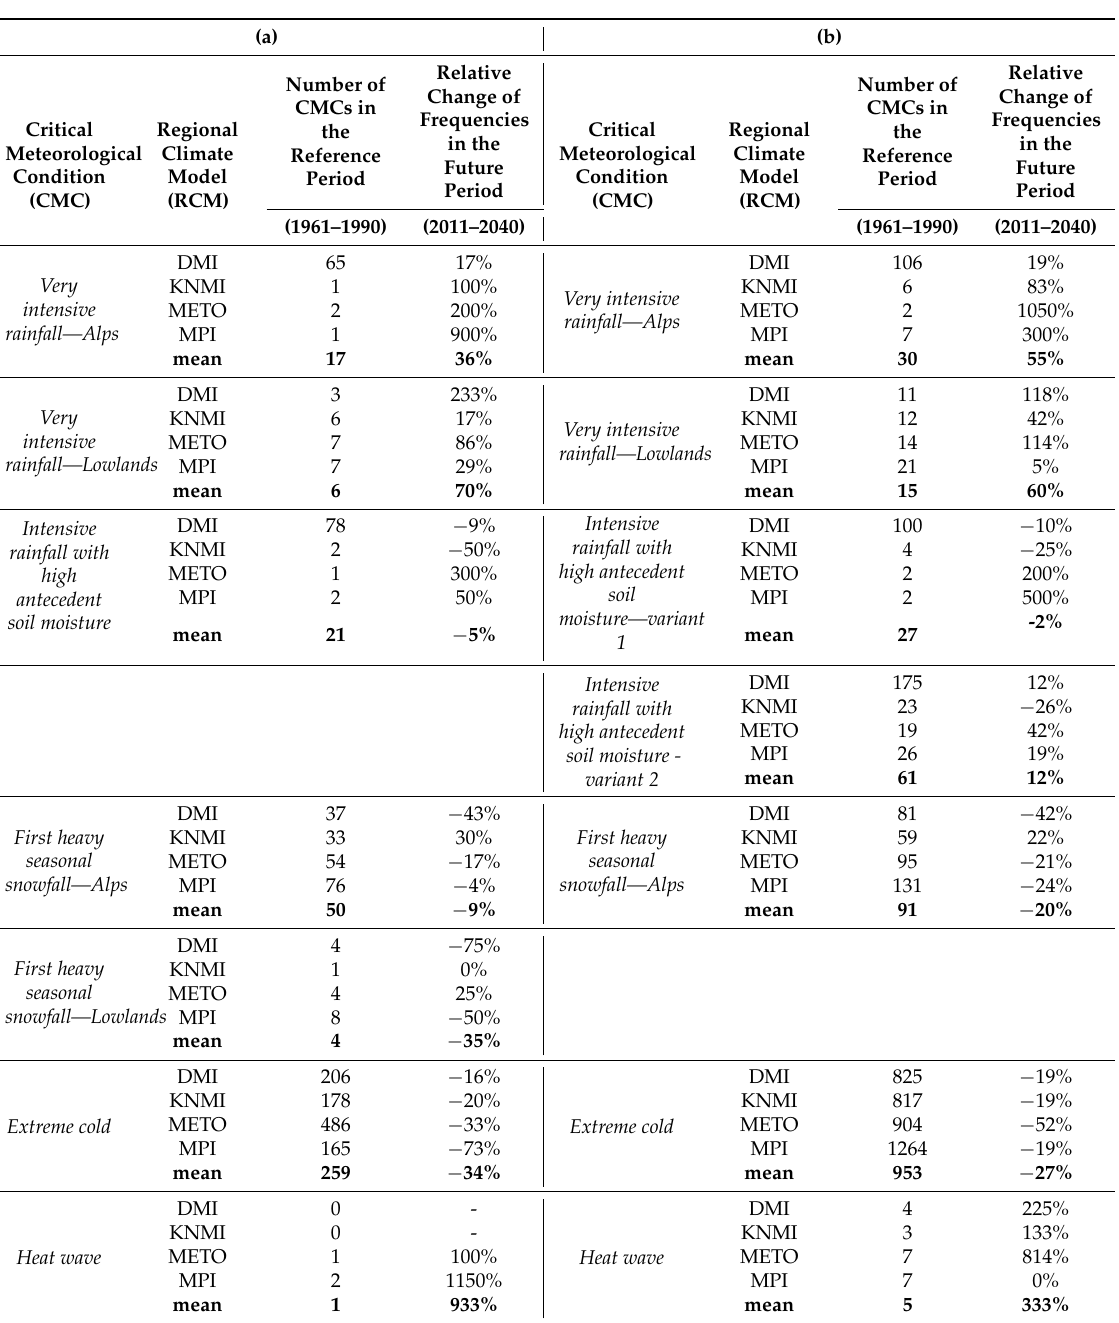
Table 5. Changes in frequencies of critical meteorological conditions (CMCs). Section ( a ) shows the changes in frequencies of CMCs (see Table 1a) between the reference period 1961–1990 and the projection period 2011–2040 based on individual RCM simulations. The mean relative change of the individual CMC frequency for the projection period is calculated on the basis of the absolute mean values of all model results for both periods (see text for the abbreviations). In Section ( b ), the changes in frequencies of CMCs resulting from the modification of the threshold criteria (see Table 1b) are depicted. The mean relative change of the individual CMC frequency for the projection period is calculated on the basis of the absolute mean values of all model results for both